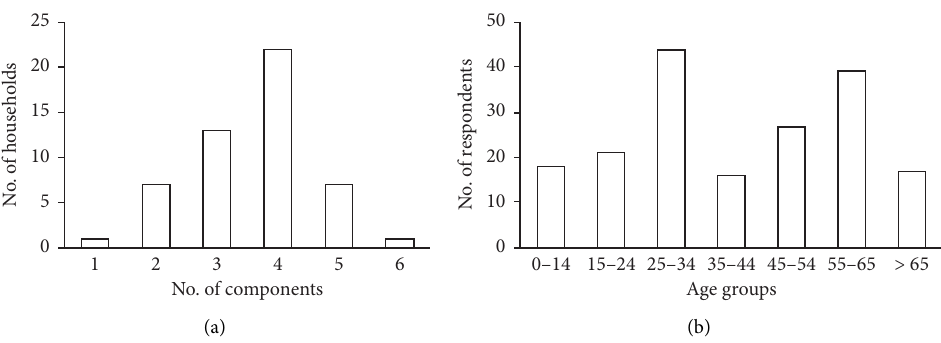
Figure 2: (a) Household number of components; (b) age